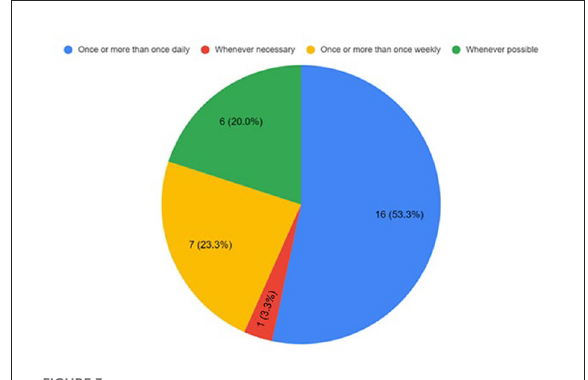
FIGURE3 Utilization of the ReWin intervention by participants at